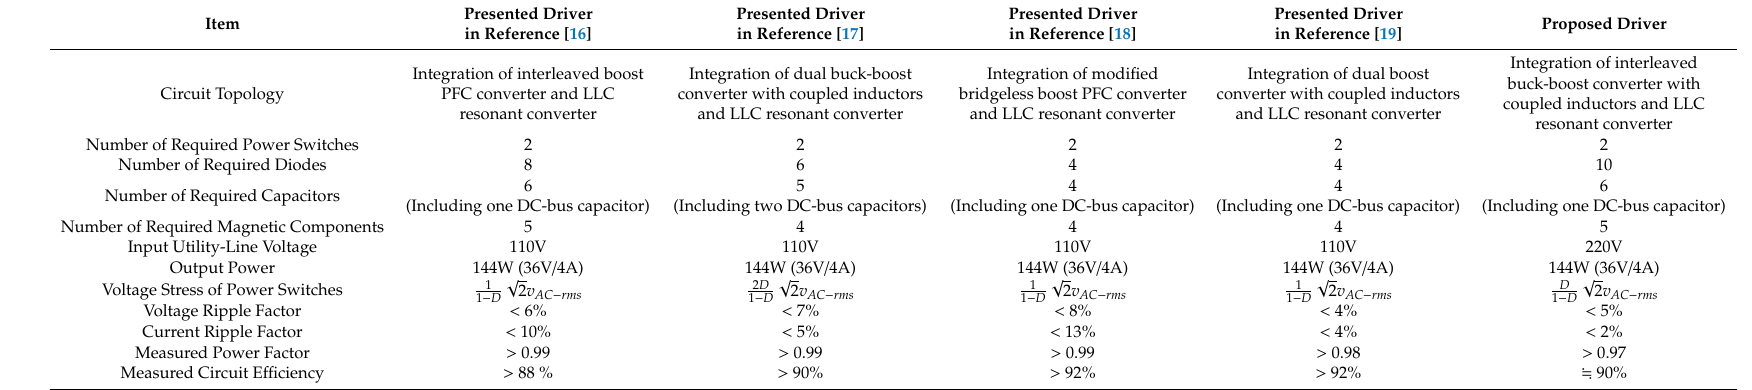
Table 4. Comparisons between the existing single-stage LED streetlight driver in [16–19], and the version proposed in this